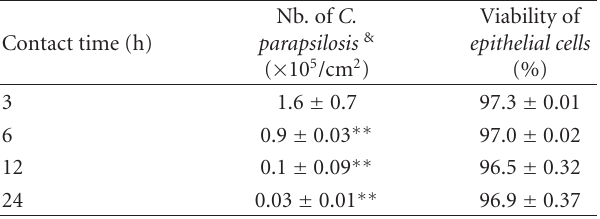
Table 2: Growth of C. parapsilosis following contact with human oral epithelial cells, and viability of epithelial cells after contact with Candida